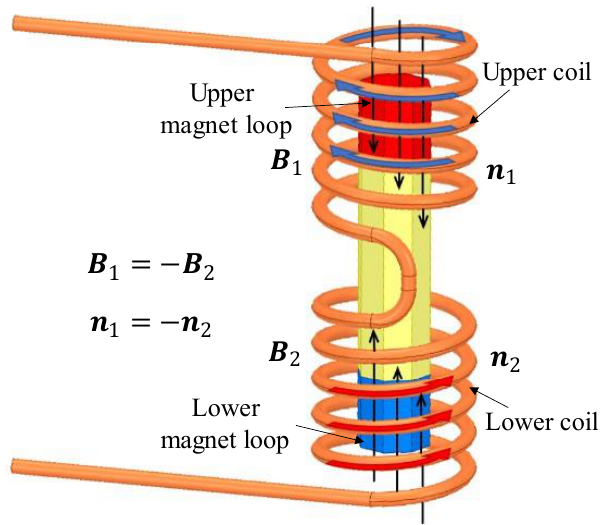
Figure 14. The opposite direction of the induced magnetic field. The solid red and solid blue rep- resent two magnet loops with opposite magnetized directions.